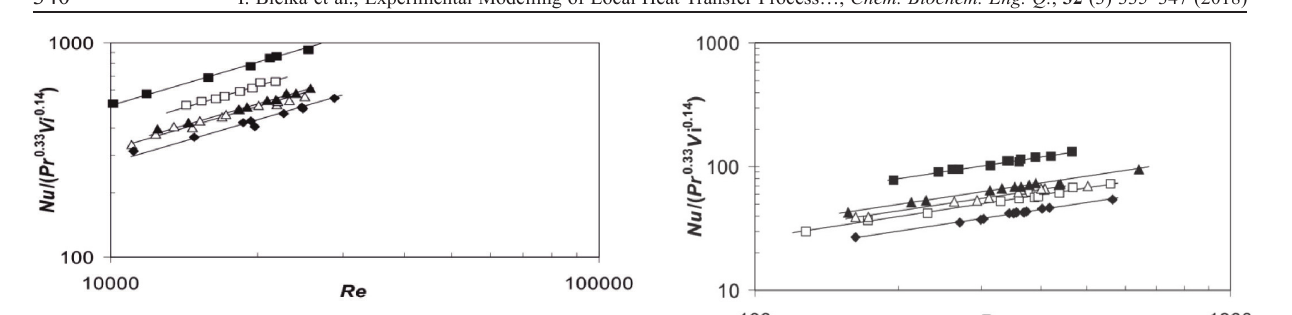
Fig. 5 – The dependence Nu/(Pr 0.33 Vi 0.14 ) = f(Re) for 30 % aqueous solution of glucose (w = 0 m s –1 ) and different posi­ Fig. 8 – The dependence Nu/(Pr 0.33 Vi 0.14 ) = f(Re) for glycerol og tions of the dimensionless axial coordinate z/H; lower impeller (w = 5.1 · 10 –3 m s –1 ) and different positions of the dimension­ og – A 315, upper impeller – RT,  – z/H = 0.07; D – z/H = 0.16; less axial coordinate z/H; lower impeller – A 315, upper impel­  – z/H = 0.42;  – z/H = 0.67; ▲– z/H = 0.82; experimental ler – RT,  – z/H= 0.07; D – z/H = 0.16;  – z/H = 0.42;  points obtained using thermal method – z/H = 0.67; ▲– z/H = 0.82; experimental points obtained using thermal